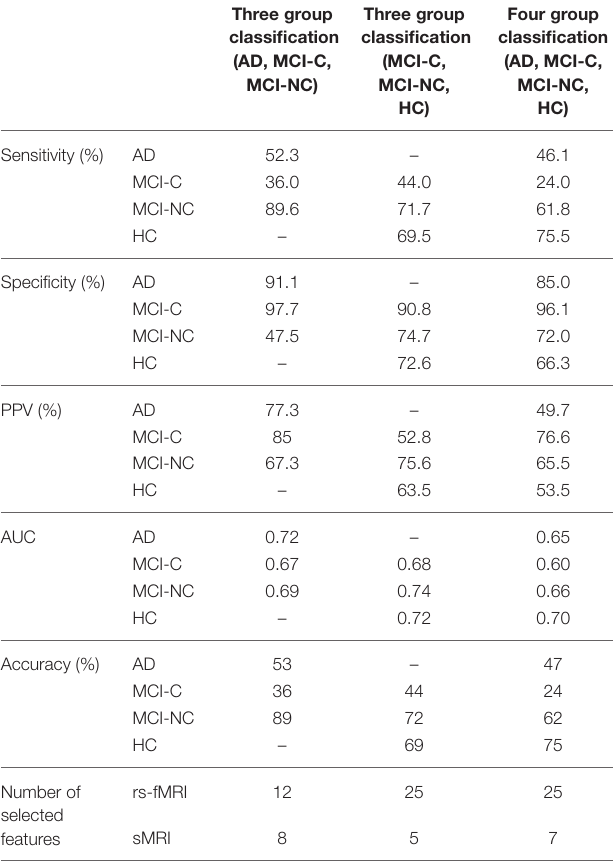
TABLE 3 | Sensitivity, specificity, positive predictive value (PPV), AUC, and accuracy of three- and four-group classification based on the SFC feature selection algorithm. SFC 67.6% DCA 57.6% SFC 66.0% DCA 58.2% SFC 56.1% DCA 48.8%